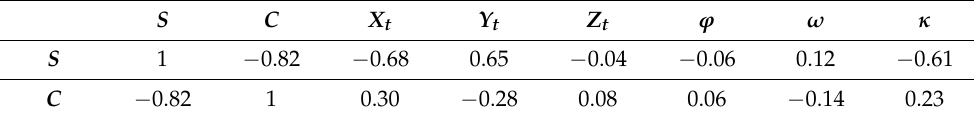
Table 8. The matrix of correlation coefficients of the unknowns for calibration data.